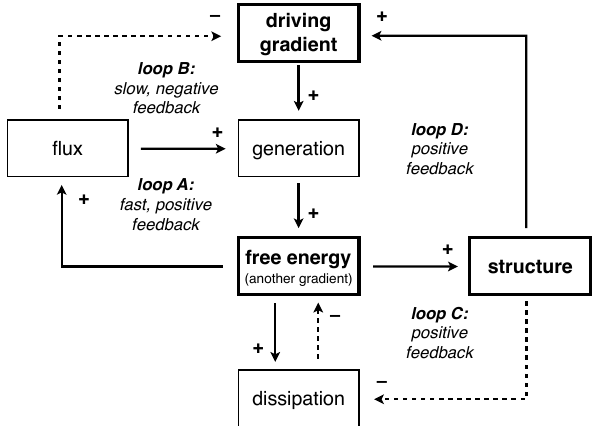
Fig. 9. A general feedback diagram to illustrate how the dynamics of free energy generation enhance gradient depletion and how these dynamics relate to structure formation. Solid lines with “+” indicate positive influences (e.g. a larger driving gradient results in a greater generation rate). Dashed lines with “ − ” show negative influences (e.g. an enhanced flux reduces the driving gradient). Four feedback loops (A, B, C, D) are shown: Feedbacks A and B on the left relate to the maximum power limit, and the feedbacks C and D on the right relate to how structured flow can achieve this limit. After Kleidon et al.